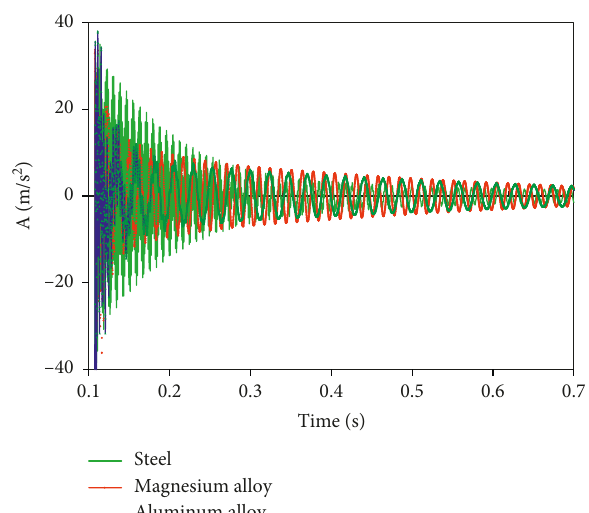
Figure 5: Vibration amplitudes of magnesium alloy, aluminum alloy, and